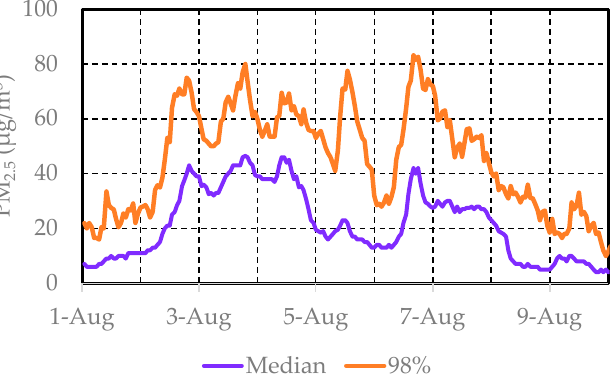
Figure 12. Median and 98% concentrations of PM 2.5 in region 8 from 1 August to 10 August